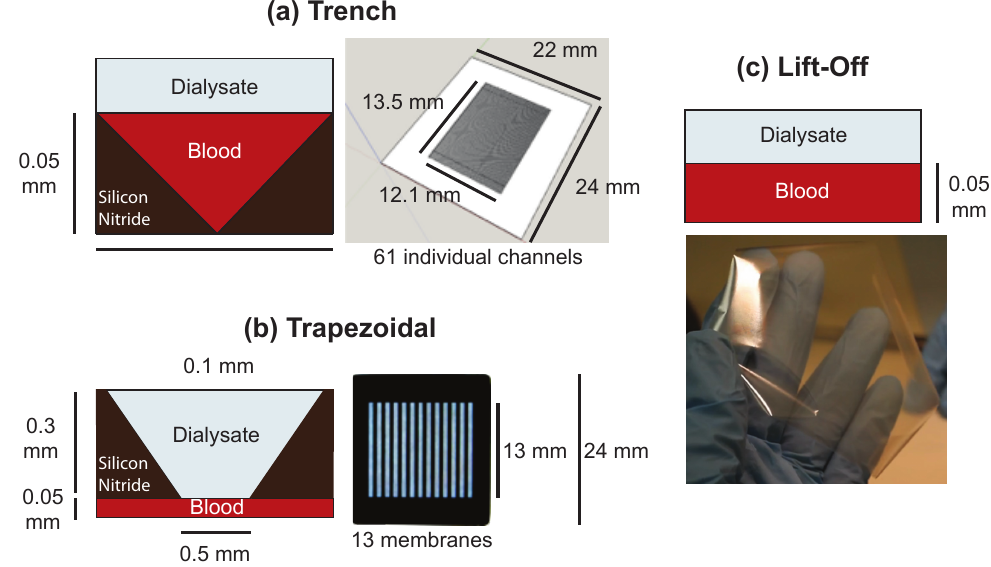
Figure 6. Depictions of the practical designs referenced in Table 2. ( a ) The trench chip design, consisting of a series of triangular channels etched under a continuous membrane. Sixty-one